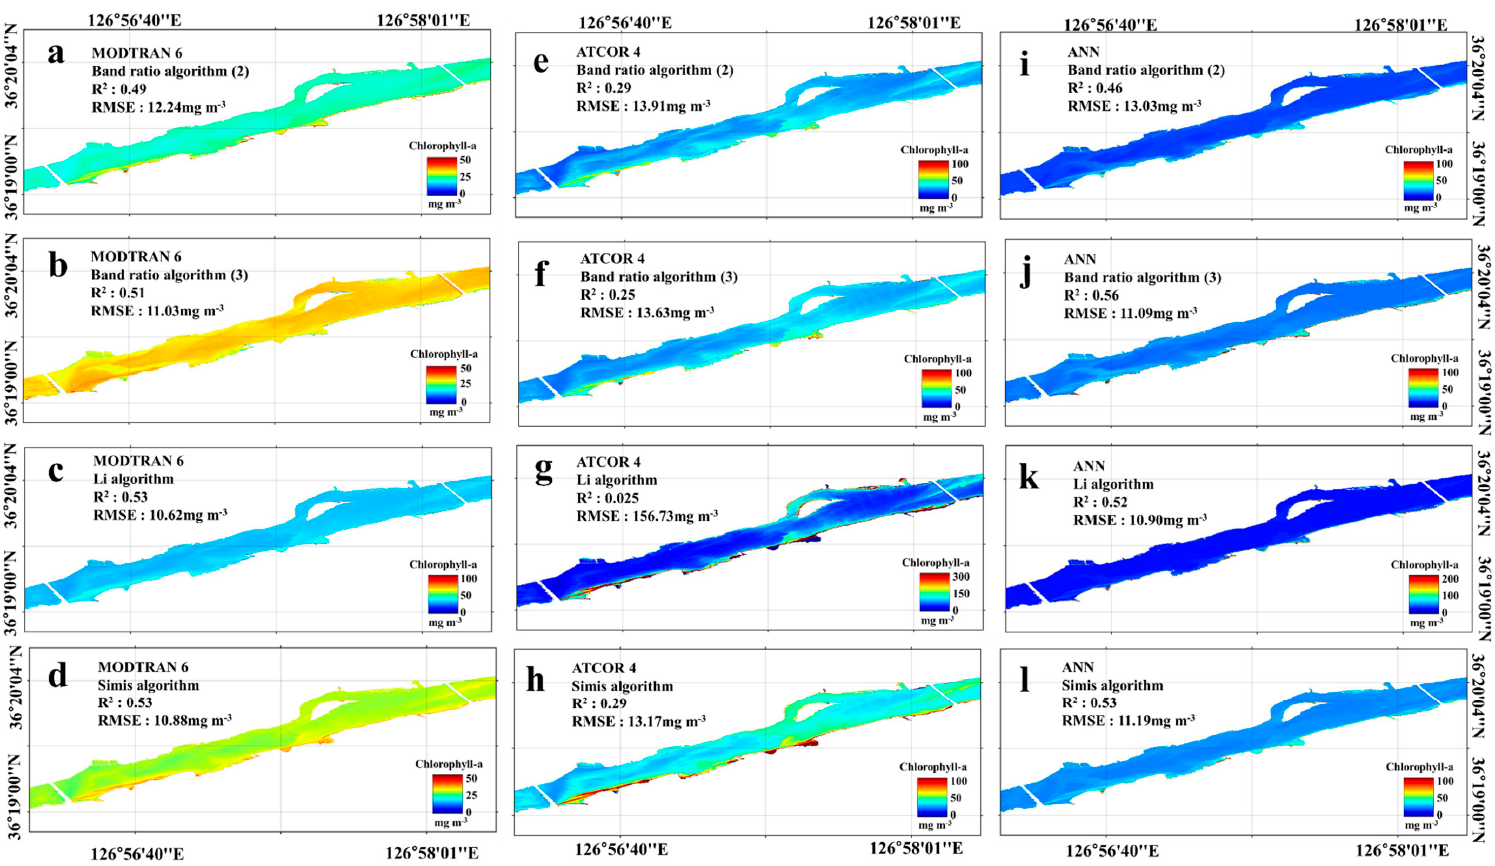
Figure 13. Chlorophyll - a (Chl-a) concentration images on 24 August 2016 in Section 1. Panels ( a – d ) show the Chl-a distribution driven by the MODTRAN 6 atmospheric correction. Panels ( e – h ) show the Chl-a distribution driven by the ATCOR 4 atmospheric correction. Panels ( i – l ) show the Chl-a distribution driven by the ANN atmospheric correction.